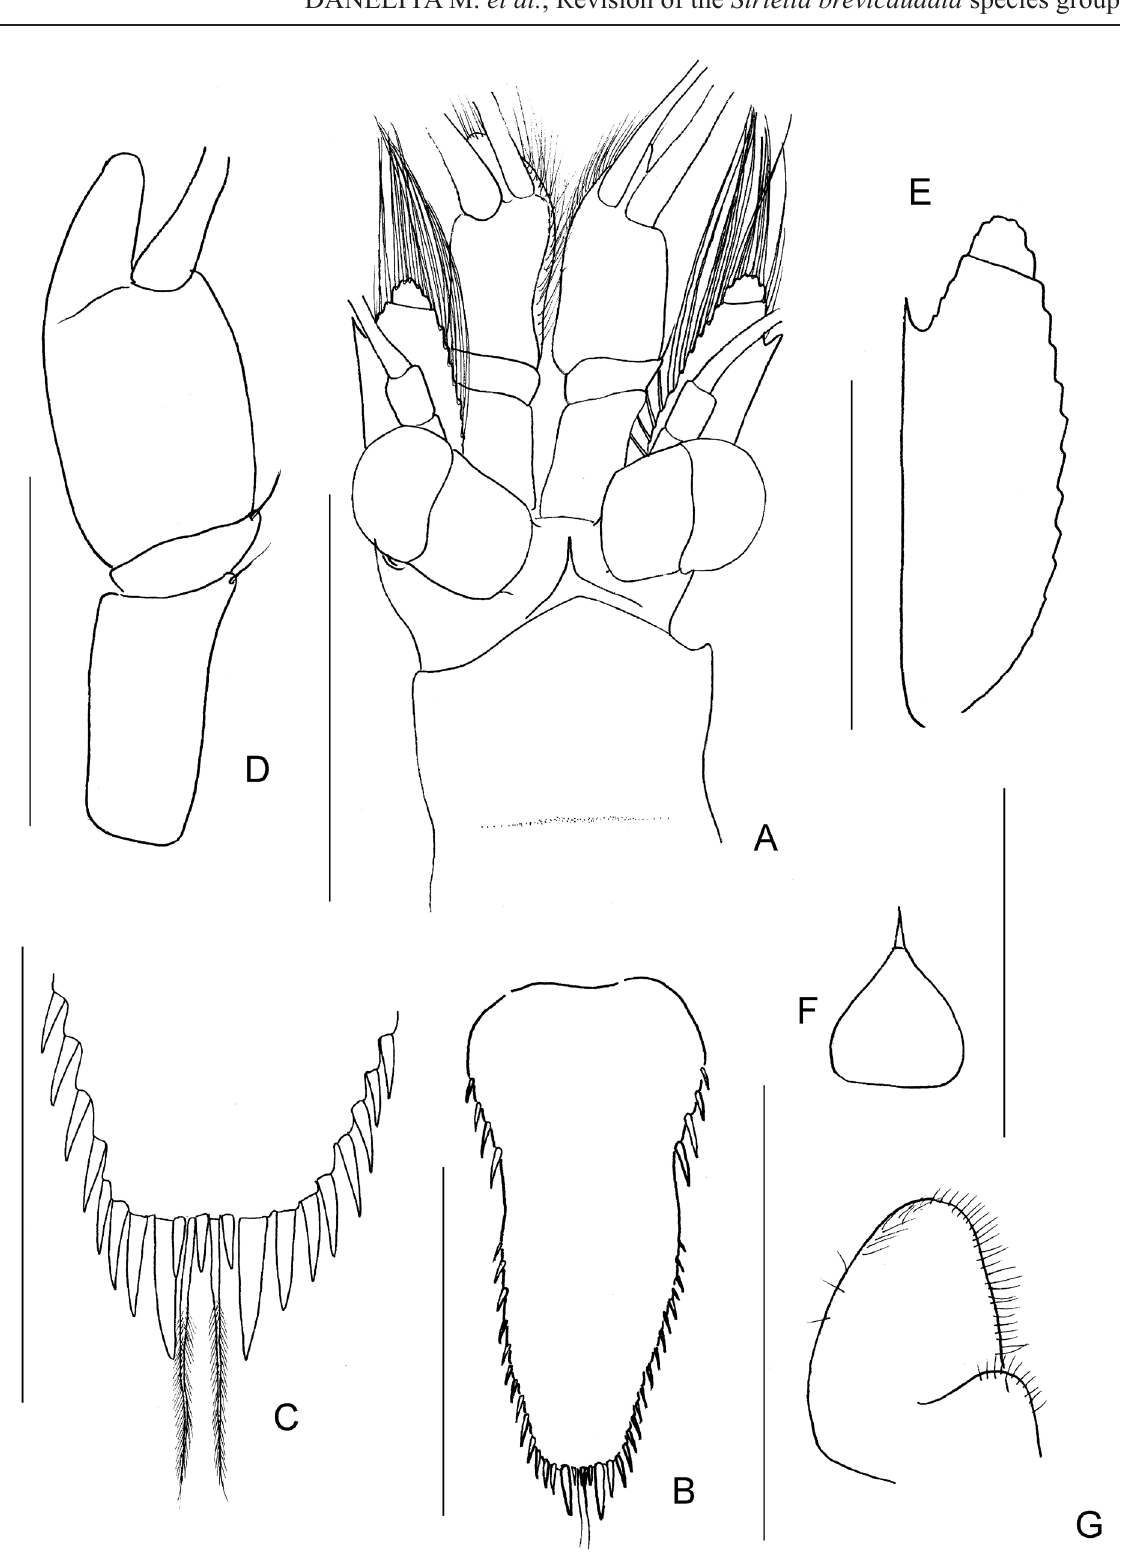
Fig. 26. Siriella talbotae sp. nov., holotype, ♂, length 5 mm, Lizard Island, Queensland, Australia. A . Anterior part of body. B . Telson. C . Posterior part of telson, dorsal view. D . Peduncle of antenna 1, dorsal view. E . Antennal scale. F . Labrum. G . Labium (left part not shown), posterior view. Scale bars: A = 1 mm; B, D–F = 0.5 mm; C, G = 0.25